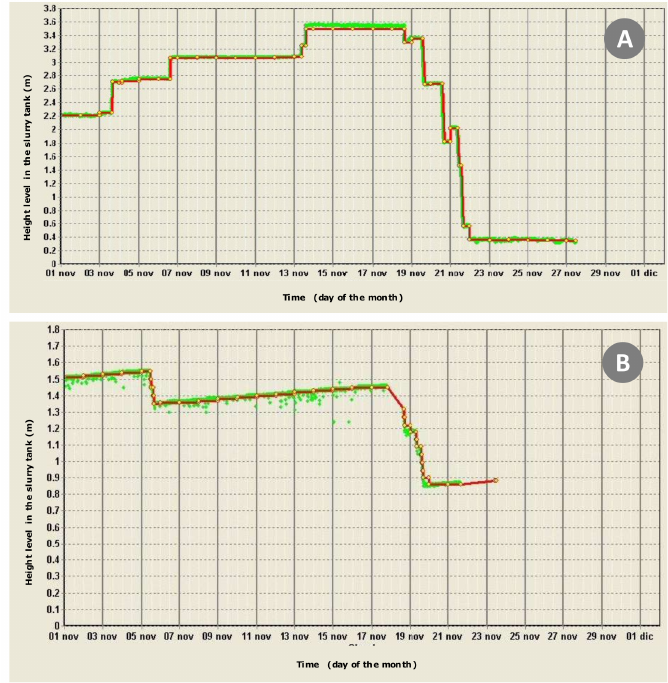
Figure 12. Examples of monthly slurry level monitoring results on two di ff erent storage structures (logging frequency: 6 h − 1 ). An inference engine converts raw data (green points) into stable level benchmarks (red